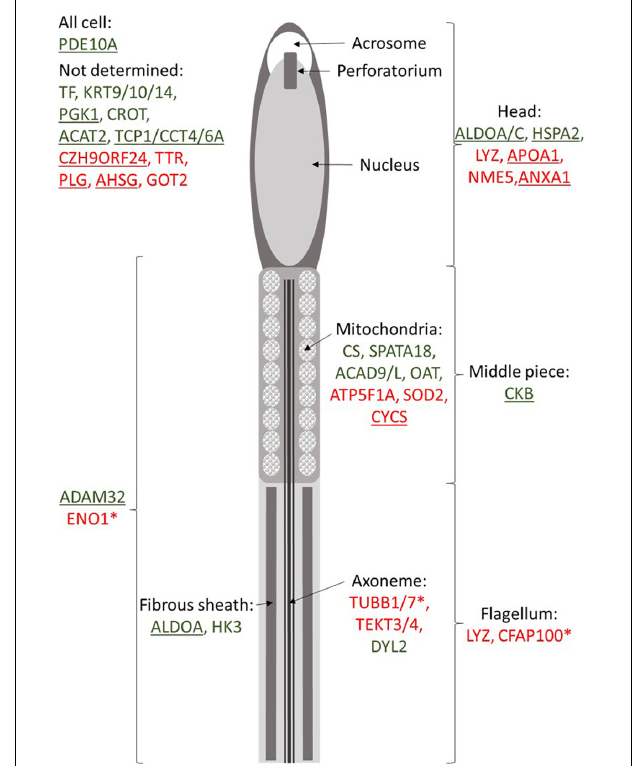
FIGURE 5 | Putative localization of proteins identified as relative to meat-line rooster fertility. Peptidoforms resulting from protein degradation revealed by ICM-MS are noted with asterisks. Green indicates proteins more abundant in fertile animals, and red represents proteins and peptidoforms more abundant in subfertile roosters. Underlined proteins are the one present in chicken seminal plasma (Labas et al.,